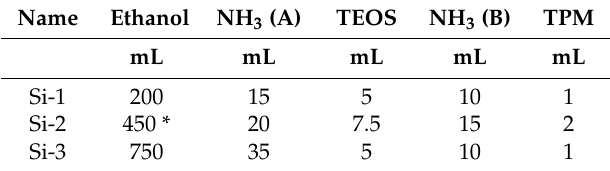
Table 1. Specific amounts of chemicals used for the Synthesis of the TPM-grafted silica particles.